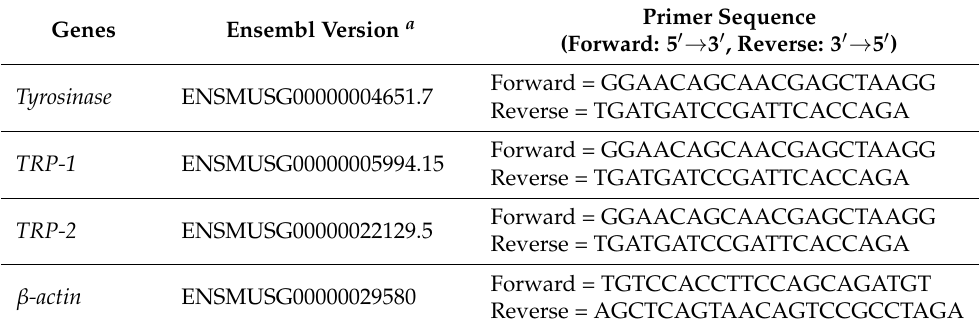
Table 1. Primer sets used for